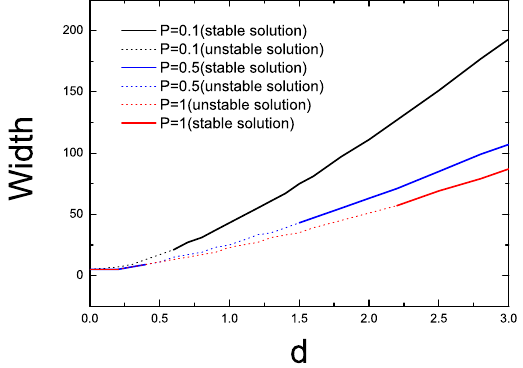
Figure 2. Widths of dark solitons for different d and P